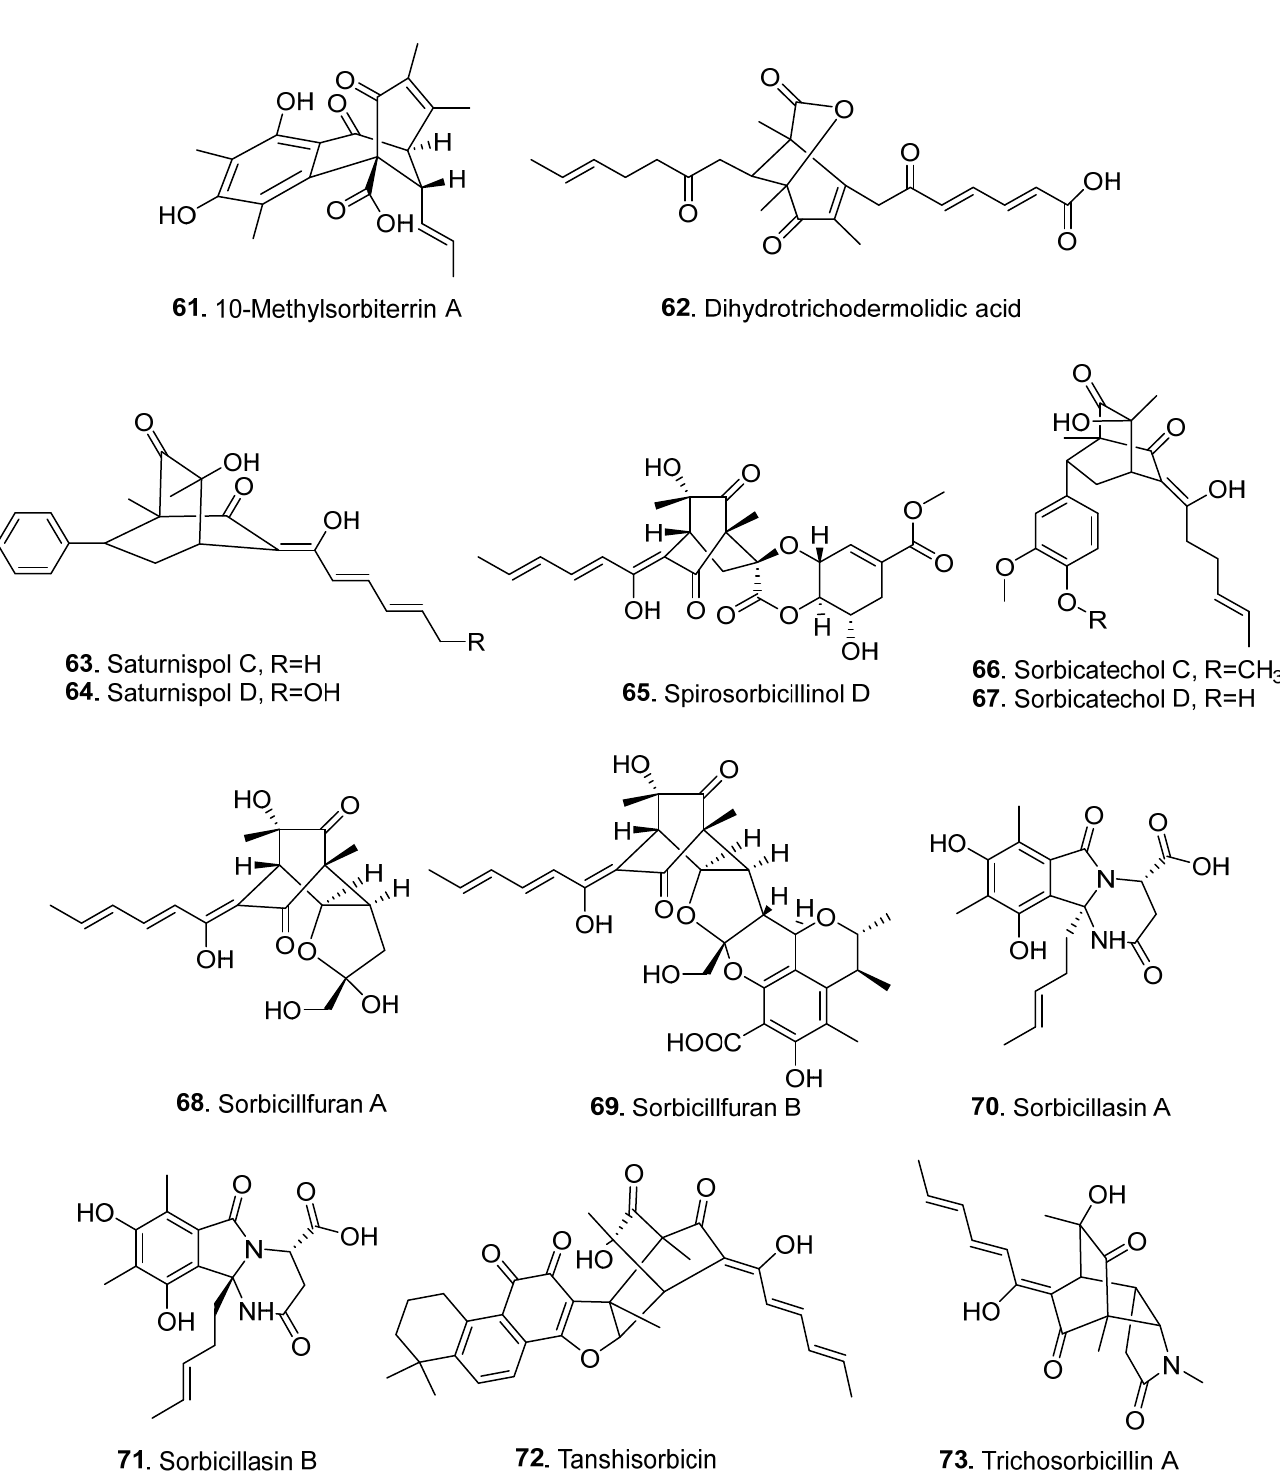
Figure 5. Structures of the hybrid sorbicillinoids ( 61 – 73 ) isolated from